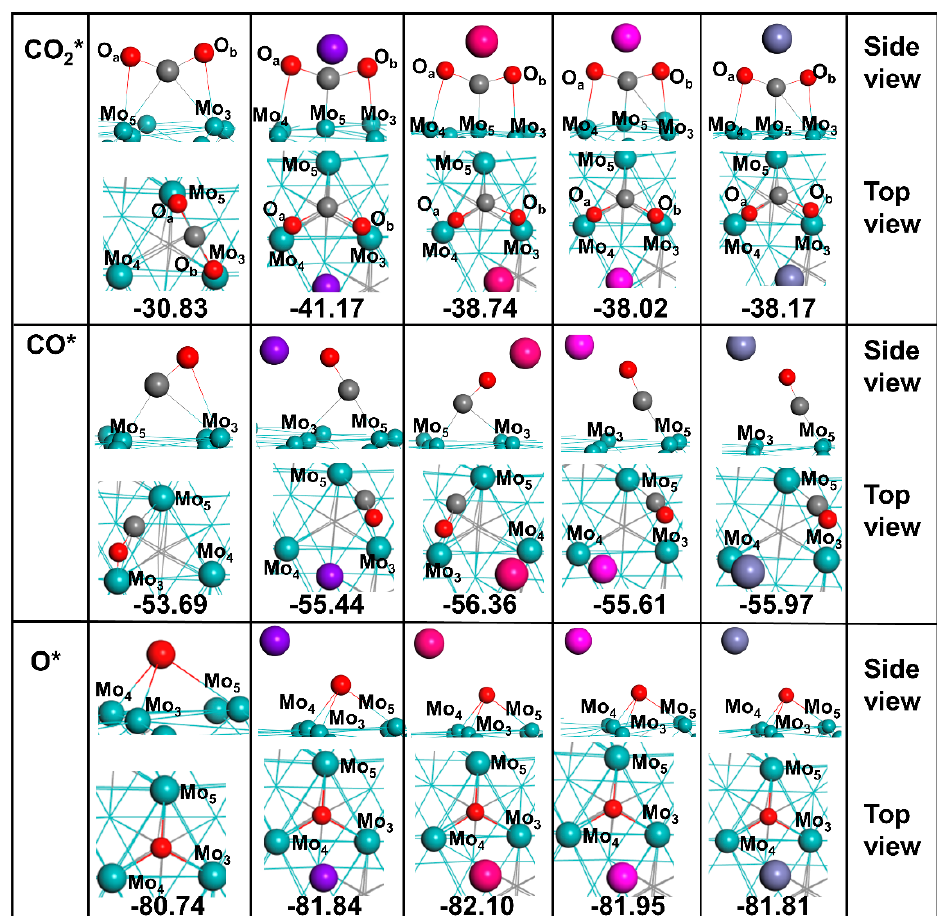
Figure 3. Schematic mechanism diagram of redox pathway in the RWGS reaction. The species with asterisks (*) represent adsorbed species.